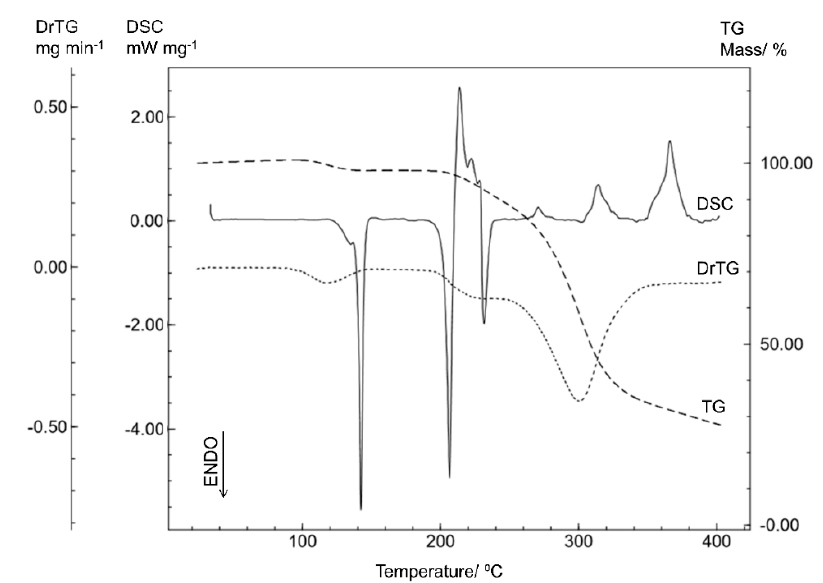
Figure 2. The di ff erential scanning calorimetry (DSC) and thermogravimetry / derivative Figure 2. The differential scanning calorimetry (DSC) and thermogravimetry/derivative thermogravimetry (TG / DTG) curves of sitagliptin phosphate monohydrate (STG) obtained with thermogravimetry (TG/DTG) curves of sitagliptin phosphate monohydrate (STG) obtained with a synthetic air atmosphere (50 mL min − 1 ) and a heating rate of 10 °C min − 1 .